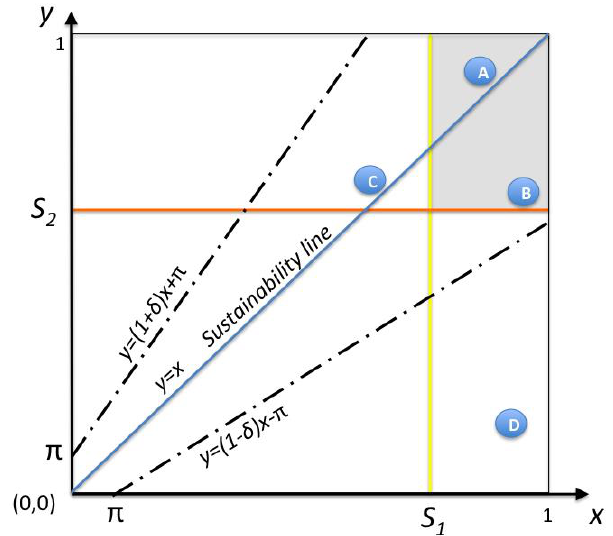
Figure 2. Two-dimensional model with a sustainability corridor.